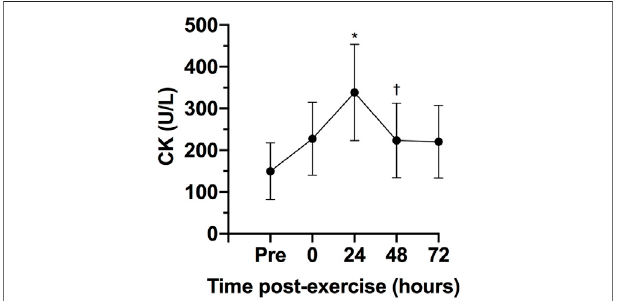
FIGURE3| Variablesareexpressedasmeanandstandarddeviation(±). Creatinekinaseconcentration(CK)duringpre-test, post-test,24,48and 72 h post-test. * p ≤ 0.05 for pre-exercise; † p ≤ 0.05 for 24-h